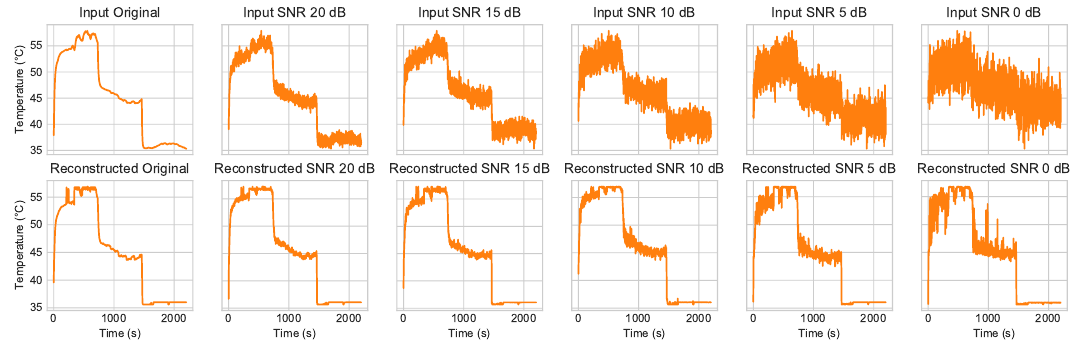
Figure 3. Plots of noisy data collected at the TS1 sensor with different signal-to-noise